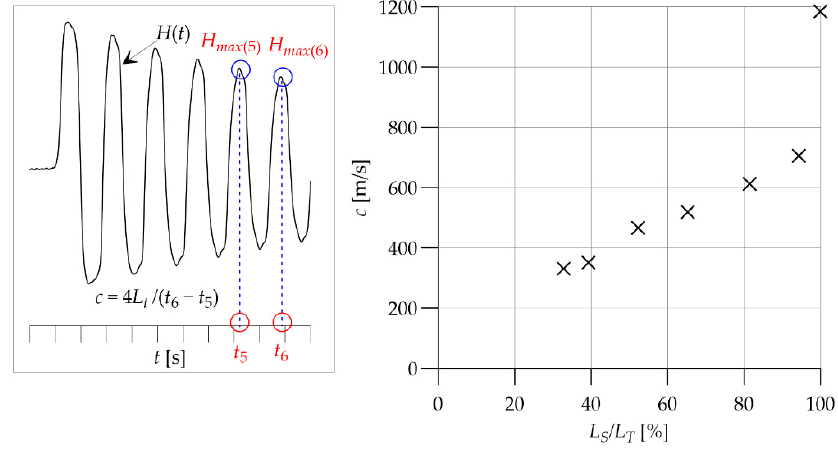
Figure 6. Values of mean pressure wave velocities in tested systems as a function of L S / L T .